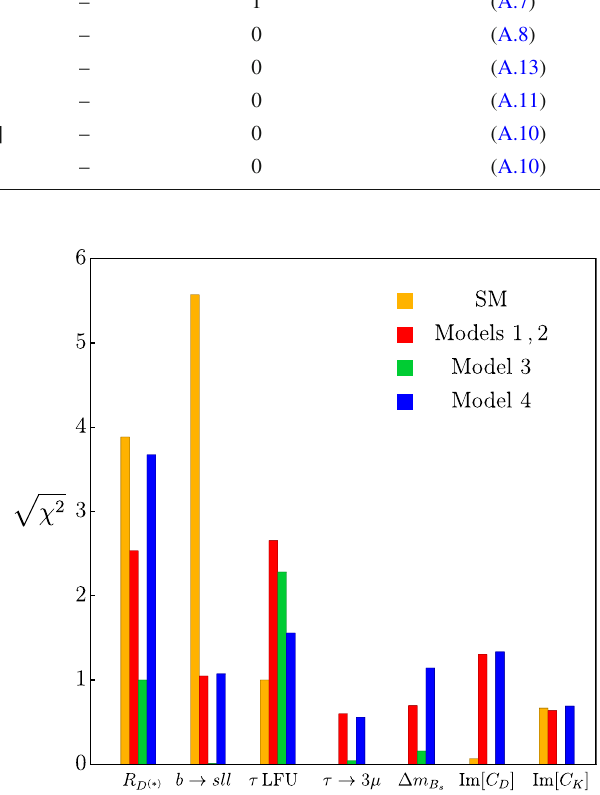
(cid:18) χ 2 coming from each observable for